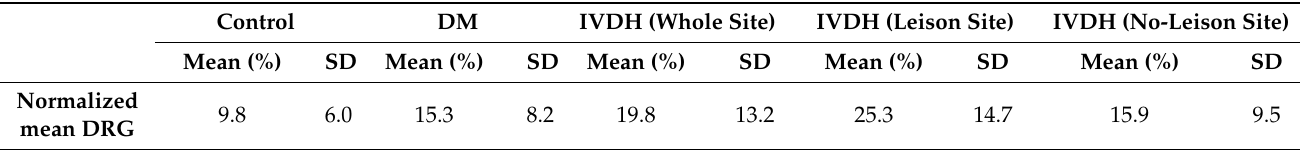
Table A2. Bilateral difference of DRG volumes 1